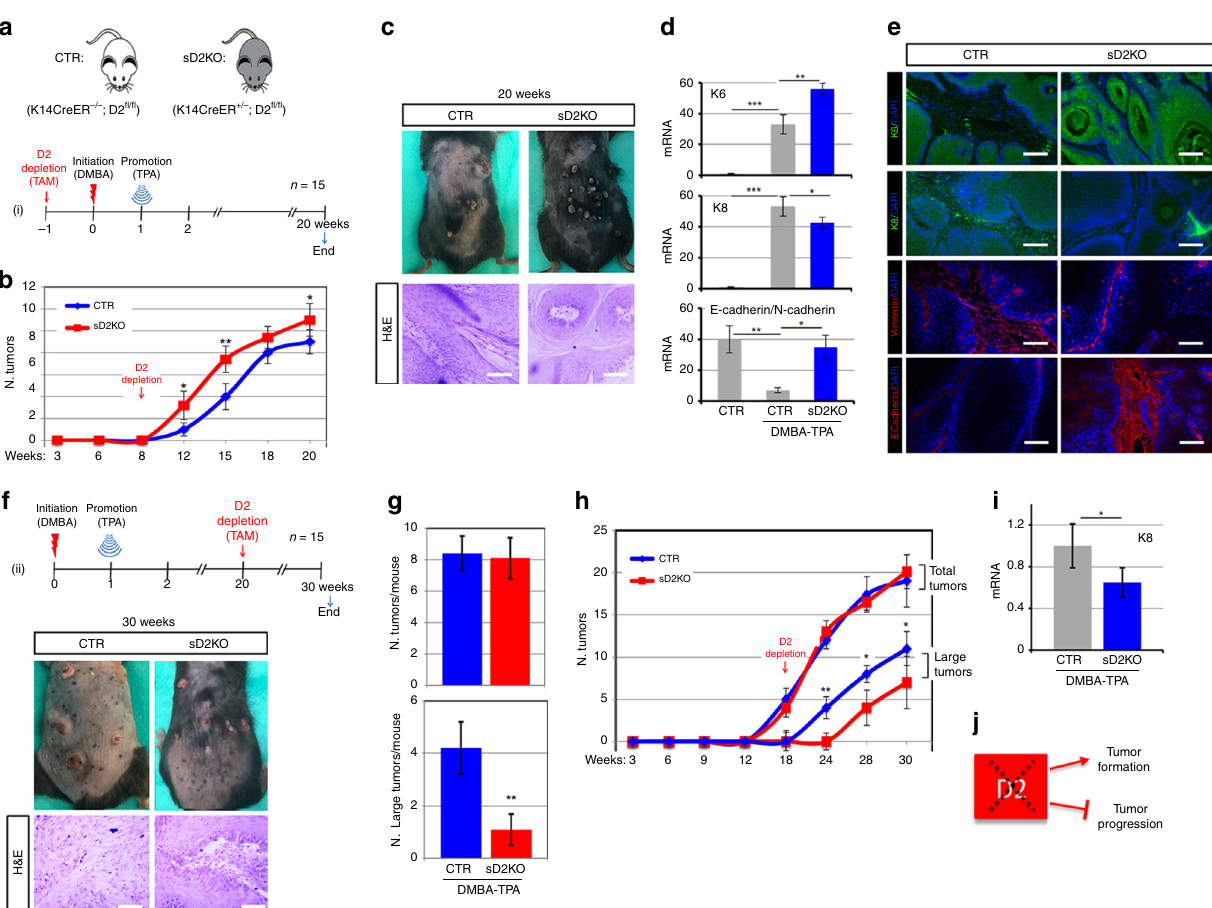
Fig. 3 Attenuation of TH signaling in D2KO mice enhanced tumor growth and reduced the EMT. a Schematic representation of D2-depletion and the two- step carcinogenesis experiment in 15 CTR and 15 sD2KO samples ( n = 15). b The number of skin lesions counted during DMBA/TPA treatment in sD2KO and CTR mice. c Picture of the dorsal skin from CTR ( n = 15) and sD2KO ( n = 15) mice treated with DMBA/TPA for 20 weeks showing papillomas and advanced SCC (top). H&E of the skin lesions from CTR ( n = 8) and sD2KO ( n = 12) mice (bottom). Scale bars represent 200 μ m. d The mRNA levels of K6, K8, and E-cadherin/N-cadherin ratio in skin lesions of CTR ( n = 15) and sD2KO ( n = 15) mice measured by real-time PCR analysis. e Immunostaining for K6, K8, vimentin, and E-cadherin was performed on paraf fi n-embedded sections of dorsal skin lesions ( n = 10 for both groups). Scale bars represent 200 μ m. f Schematic representation of D2-depletion from the epidermal compartment at the end of DMBA/TPA treatment (top, n = 15). Representative pictures and H&E staining of skin lesions from sD2KO ( n = 12) and CTR ( n = 8) mice treated with DMBA/TPA for 30 weeks (bottom). Scale bars represent 200 μ m. g and h The number of tumors (detectable tumors, >1 mm) and number of large tumors ( > 3 mm) counted during DMBA/TPA treatment in sD2KO and CTR mice. i mRNA levels of K8 in skin lesions of CTR ( n = 15) and sD2KO ( n = 15) mice measured by real-time PCR analysis. * P < 0.05, ** P < 0.01, *** P < 0.001. j Schematic representation of the effects of D2-depletion on SCC tumor growth